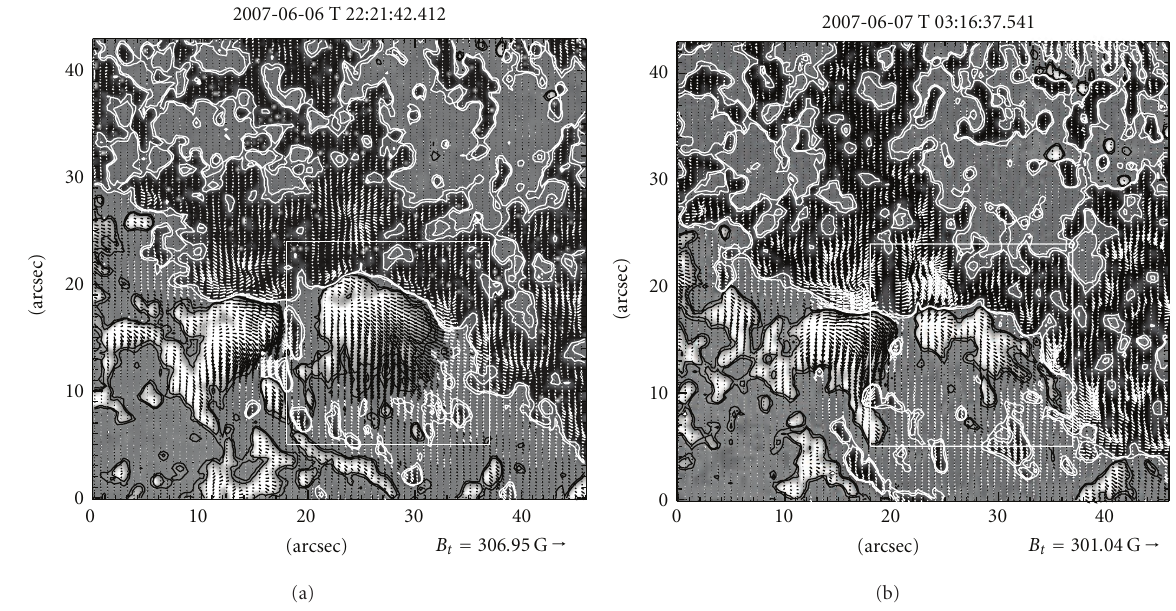
Figure 8: Transverse field vectors overlaid upon the vertical component of the magnetic field. (a) Images are obtained before the C1.7 class flare, and (b) images are obtained after the PLFs